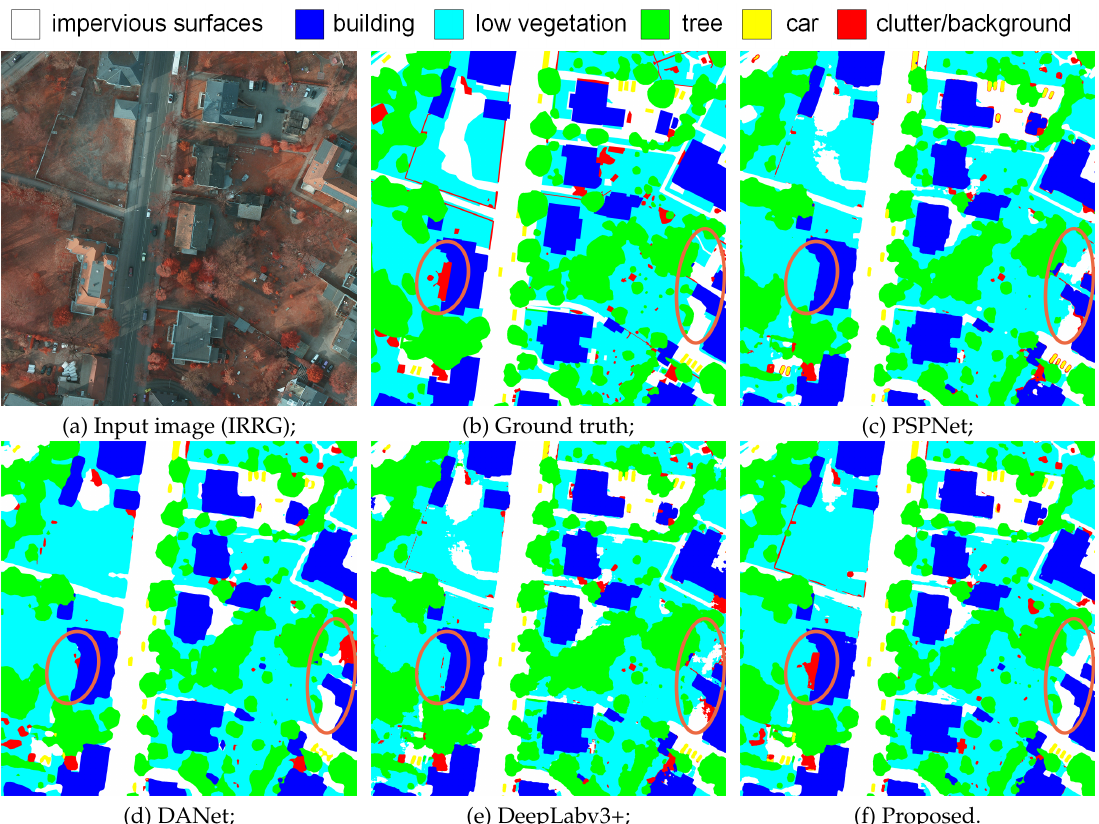
Figure 10. Classification maps produced by the compared approaches on the Potsdam dataset.